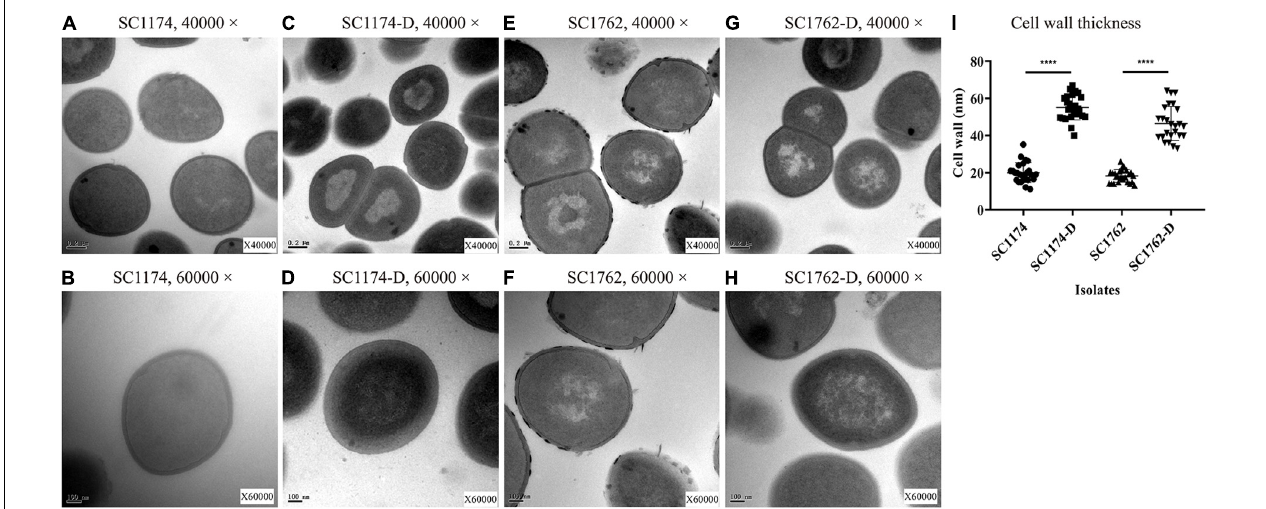
FIGURE 4 | Cell-wall thickness examined using transmission electron microscopy. (A) SC1174, 40,000 × ; (B) SC1174, 60,000 × ; (C) SC1174-D, 40,000 × ; (D) SC1174-D, 60,000 × ; (E) SC1762, 40,000 × ; (F) SC1762, 60,000 × ; (G) SC1762-D, 40,000 × ; (H) SC1762-D, 60,000 × ; and (I) the cell-wall thickness of at least 25 cells was measured for SC1174, SC1174-D, SC1762, and SC1762-D. Data were presented as the mean and standard deviation. Asterisks indicate statistical significance using the paired Student’s t -test (**** P < 0.0001).